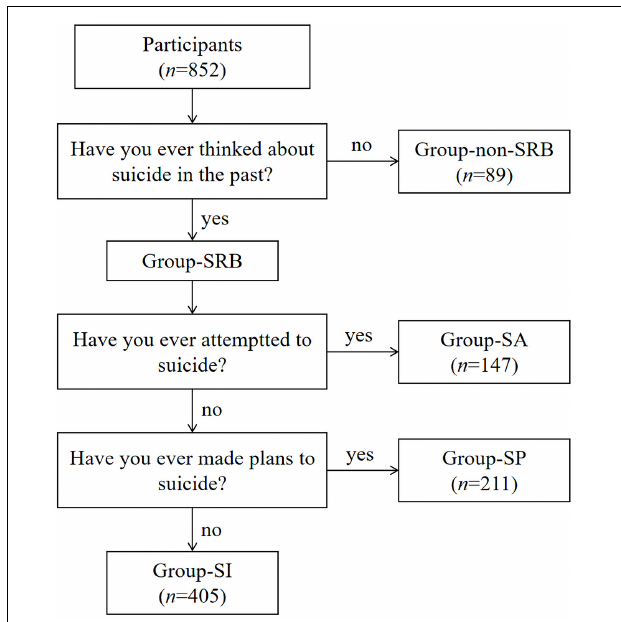
FIGURE 1 | Flowchart representing procedure of dividing participants into groups.